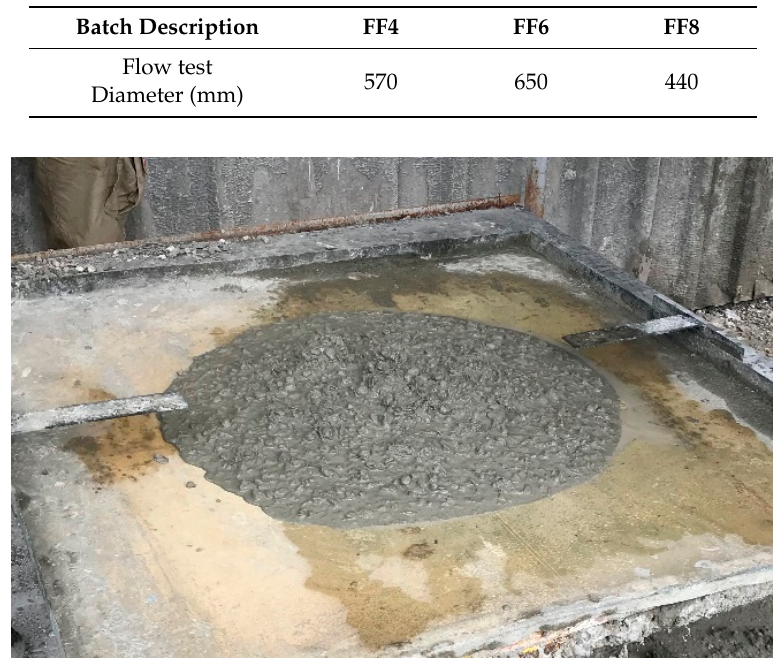
Figure 3. Flow test of FF6 giving evidence on the self-compacting properties of the material without segregation and bleeding.